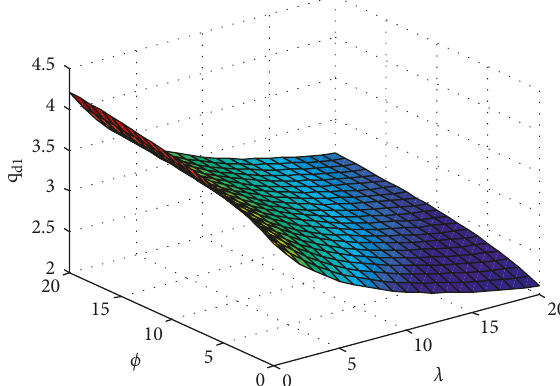
Figure 8: Impacts of dual-fairness concerns on the ordering quantity of retailer 1.